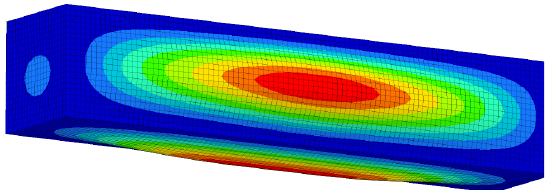
Figure 20. Structural normal shape of Mode